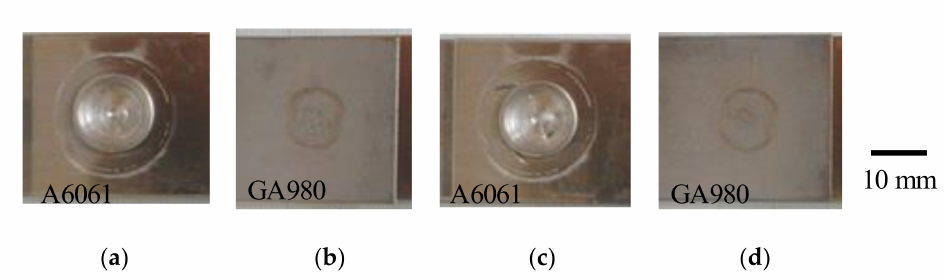
Figure 4. General views of the specimens of FSSW joints. ( a ) Welding time: 9 s, A6061 side; ( b ) welding time: 9 s, GA980 side; ( c ) welding time: 10 s, A6061 side and ( d ) welding time: 10 s, GA980